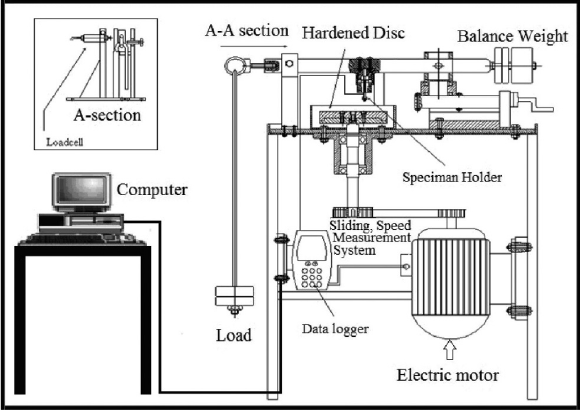
Fig. 2: A schematic diagram of prototype pin-on disc test